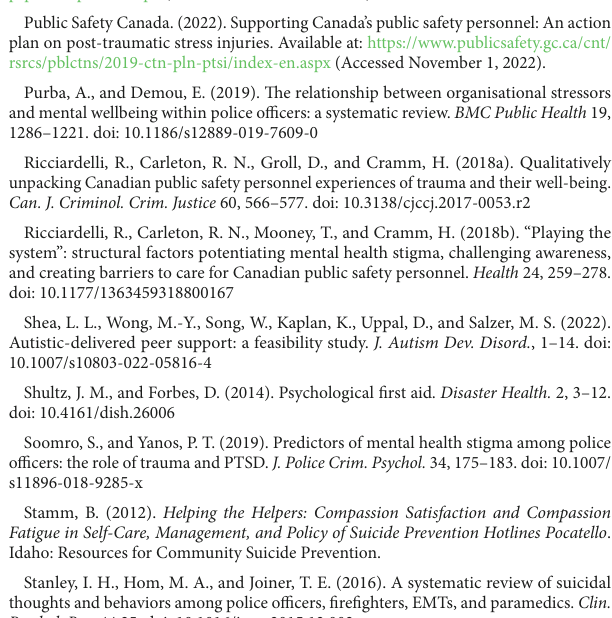
Figley, C. R. (1995). “Compassion fatigue as secondary traumatic stress disorder: An overview” in Compassion Fatigue: Coping with Secondary Traumatic Stress Disorder in those Who Treat the Traumatized . ed. C. R. Figley (New York: Brunner/Mazel),